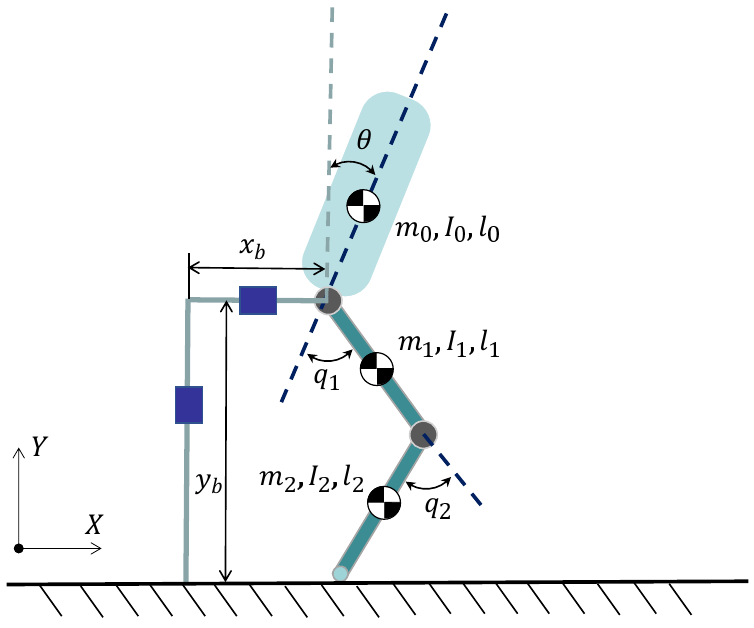
Figure 2. Coordinates and structural configuration. X b and Y b are the x and y floating-base coor- dinates. θ is the angle between the y-axis of the world frame and the torso. q 1 and q 2 are the joint coordinates of the hip and knee. m , I and l are the mass, inertia and length of a rigid